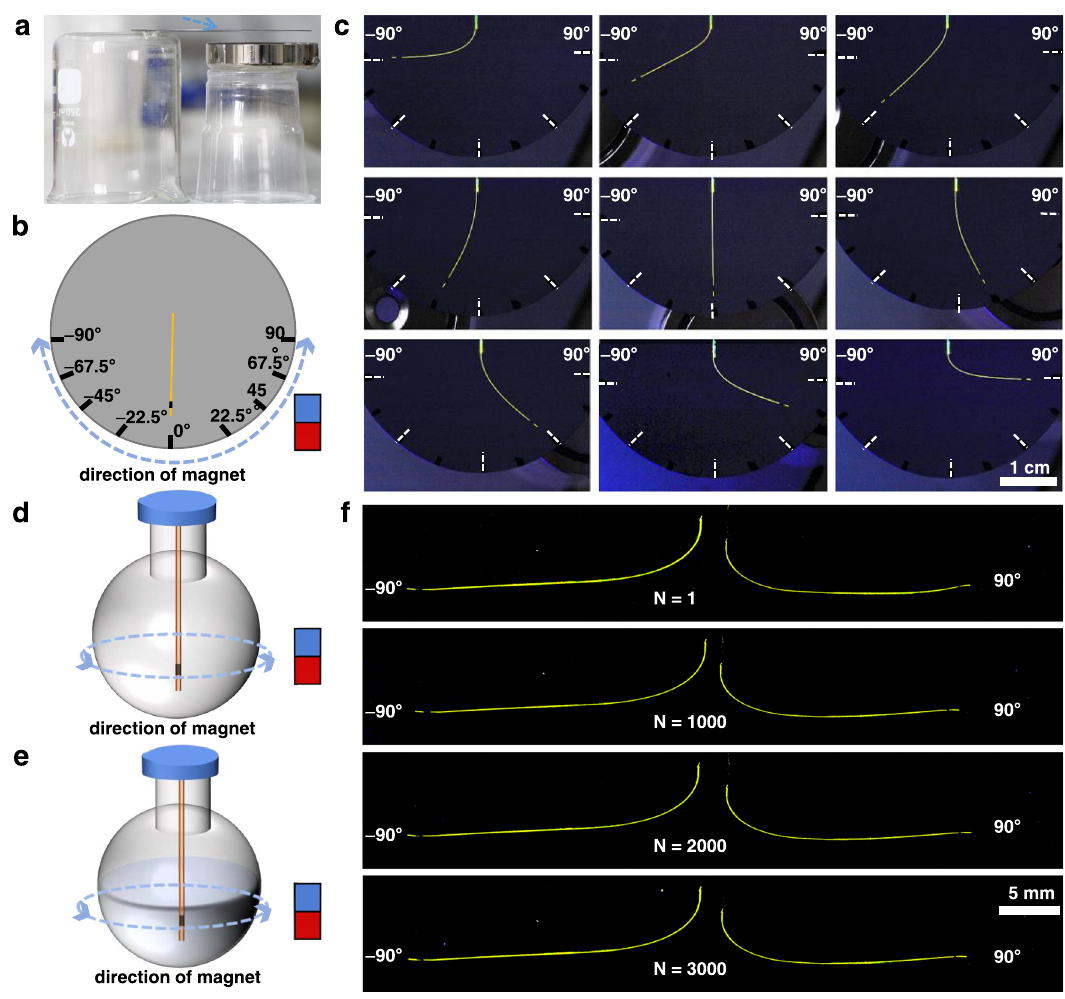
Fig. 3 Spatial control over the shape of the hybrid crystals by using magnetic fi eld. a Optical photograph of an MNP// 1 – 6 crystal bent at an arbitrary angle within a plane (side view). The blue arrow indicates the position of the crystal. b Schematic diagrams of MNP// 1 – 6 bending at an arbitrary angle in a plane. c Photographs of a crystal of MNP// 4 bending precisely towards 9 points that were marked on a silicon wafer. Note that the contrast of the color in these images was enhanced for clarity. The blue arrow represents the direction of movement of the magnet. d , e Schematic diagrams of MNP// 1 – 6 bending at an arbitrary angle in any direction in space ( d ), and in any direction in space inside a liquid ( e ). The blue arrow represents the direction of movement of the magnet. f Photographs of the MNP// 4 crystal at different times in a durability test. During the test the crystal was bent between – 90° and 90° by moving the magnet under the silicon wafer, followed by returning it to – 90°. Note that the contrast of the color in these images was enhanced